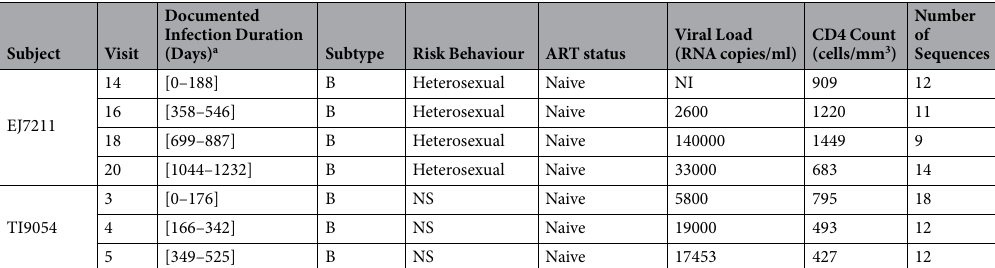
Table 1. WIHS specimens’ infection duration and viral and host factors. The minimum duration of infection of each individual was the elapsed time between the date of first HIV positive documentation and the date of specimen collection. The maximum duration of infection was the time between the last HIV negative test and blood sample collection. NS, not stated ; Naive, subject has not received ART before this time point; Experienced, patient is currently or has previously received ART; IDU, intravenous drug